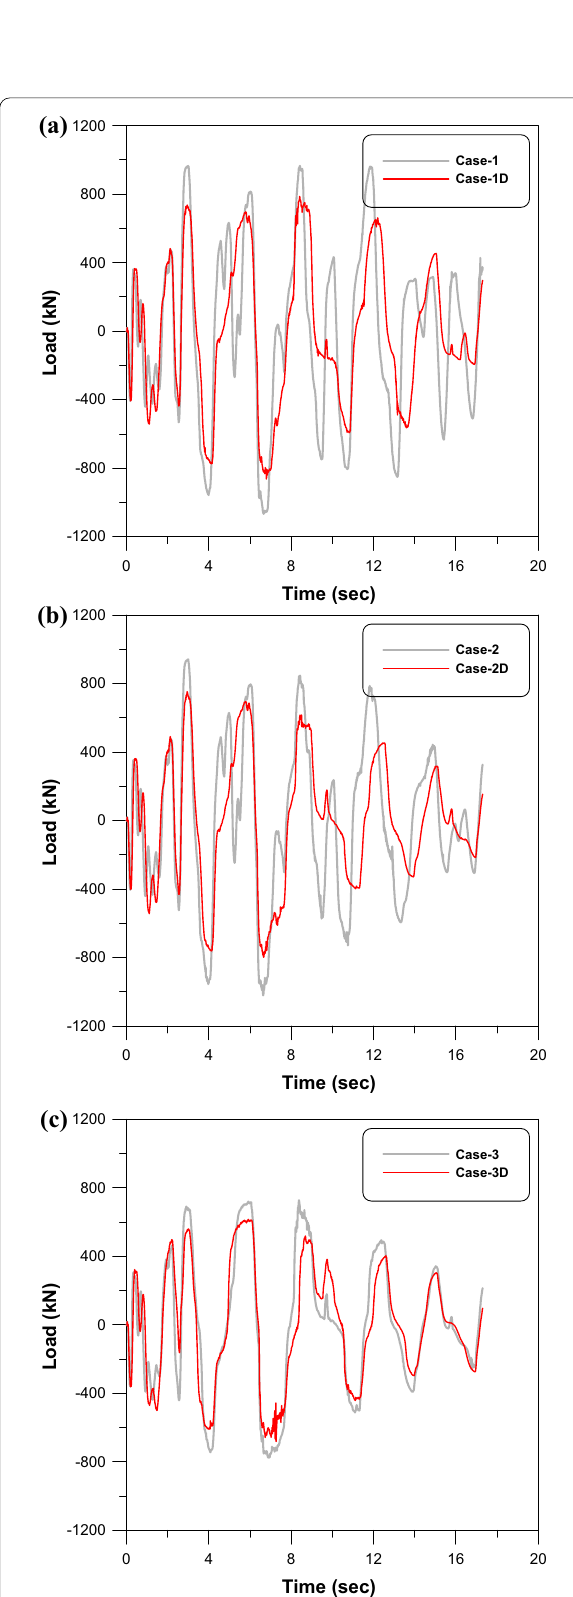
Fig. 12 Seismic responses of displacement: a Case‑1 and Case‑1D, b Case‑2 and Case‑2D and c Case‑3 and Case‑3D. Fig. 13 Seismic responses of load: a Case‑1 and Case‑1D, b Case‑2 and Case‑2D and c Case‑3 and